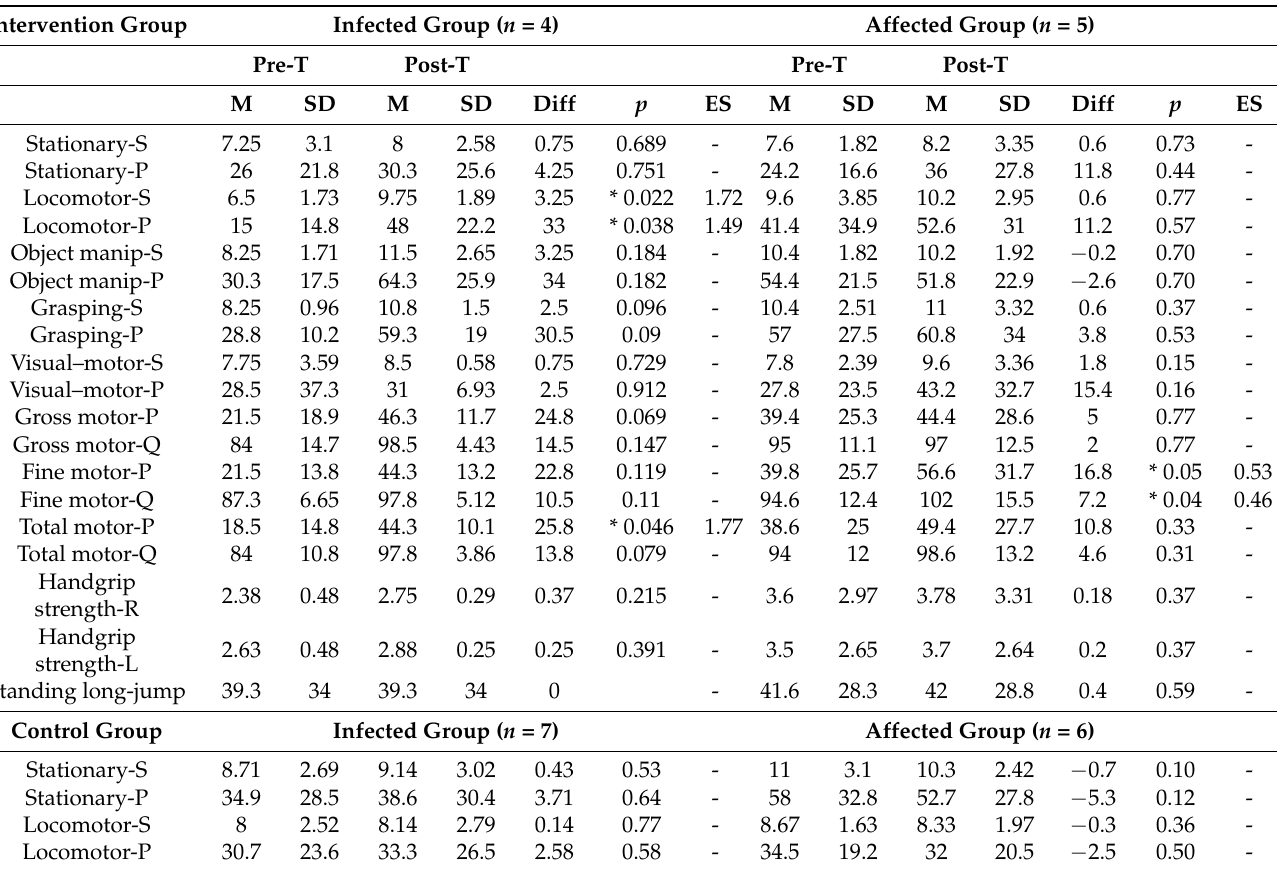
Table 5. Comparison of the pre- and post-test results of the infected and affected children in the intervention and control